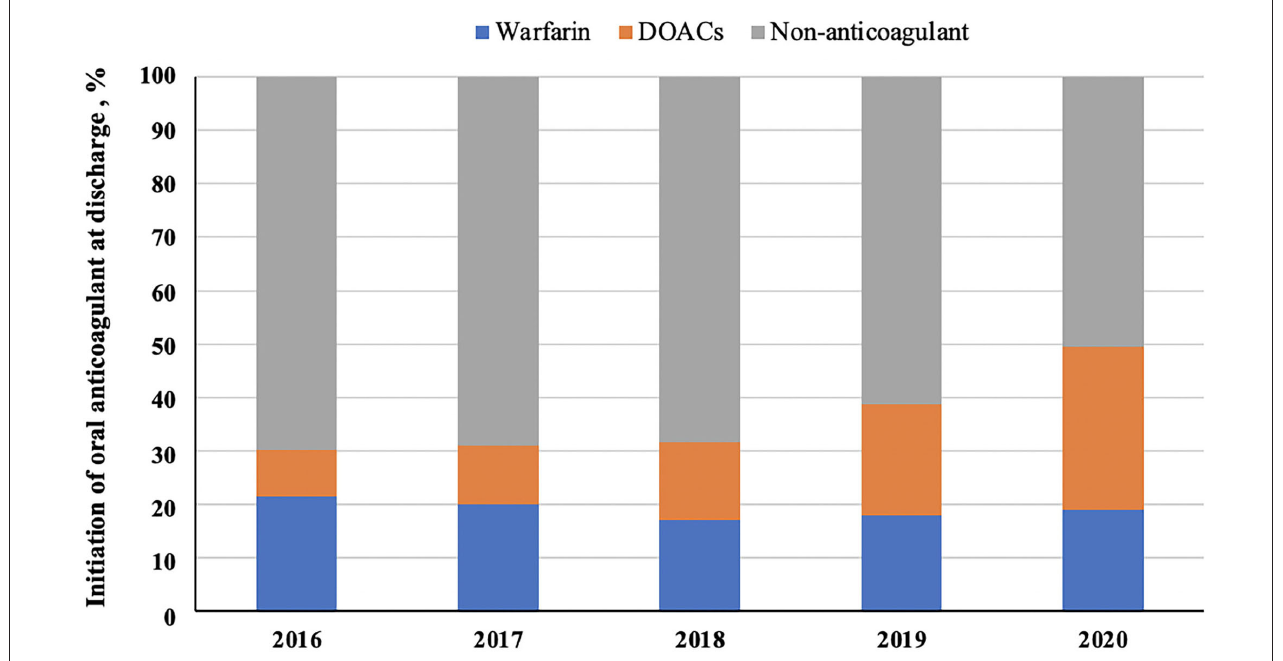
FIGURE 2 | The trends of oral anticoagulant use at discharge. DOACs indicate direct oral anticoagulants.